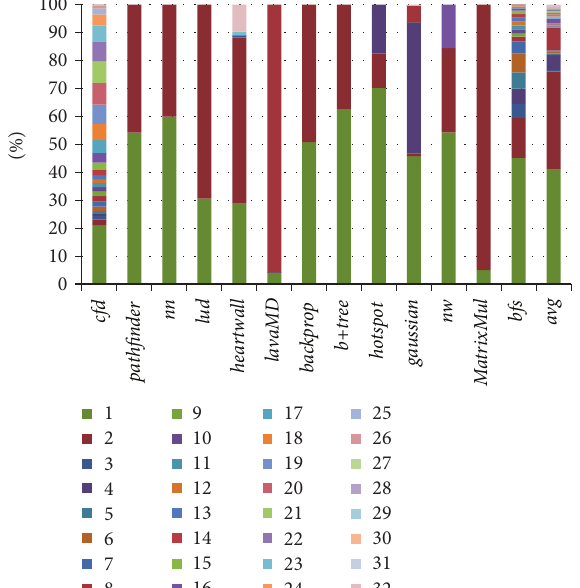
Figure 5: Memory request queue length on shared LLC.